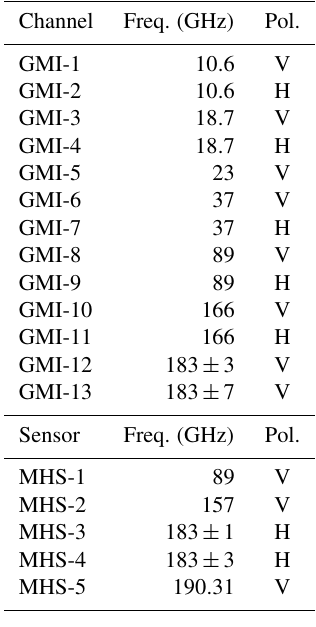
Algorithm Theoretical Basis Document (ATBD) (Passive Microwave Algorithm Team Facility, 2022). The